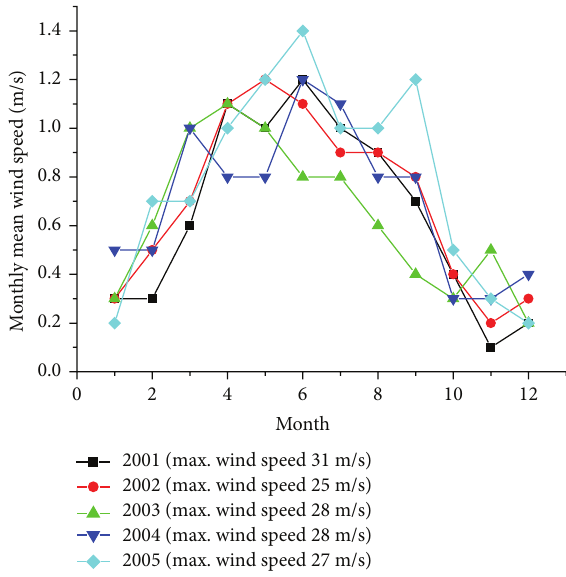
Figure 6: Wind speed data in 2001 ∼ 2005 years in Turpan region.